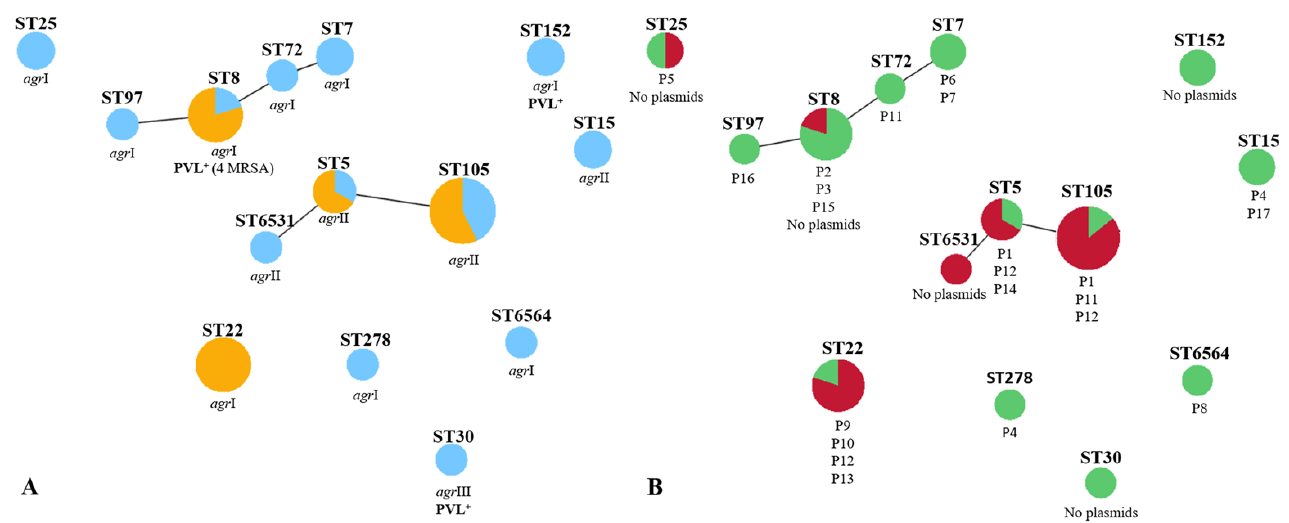
Figure 2. Relation of clonal lineages identified amongst the S. aureus associated with SSTIs in ambulatory patients determined using PHYLOViZ software and correlation with ( A ) methicillin resistance status, PVL carriage, and agr type; and ( B ) MDR phenotypes and plasmid profile. In panel A , MRSA isolates are displayed in orange whereas MSSA isolates are shown in light blue. In panel B , MDR isolates are presented in red, while non-MDR isolates are shown in green.